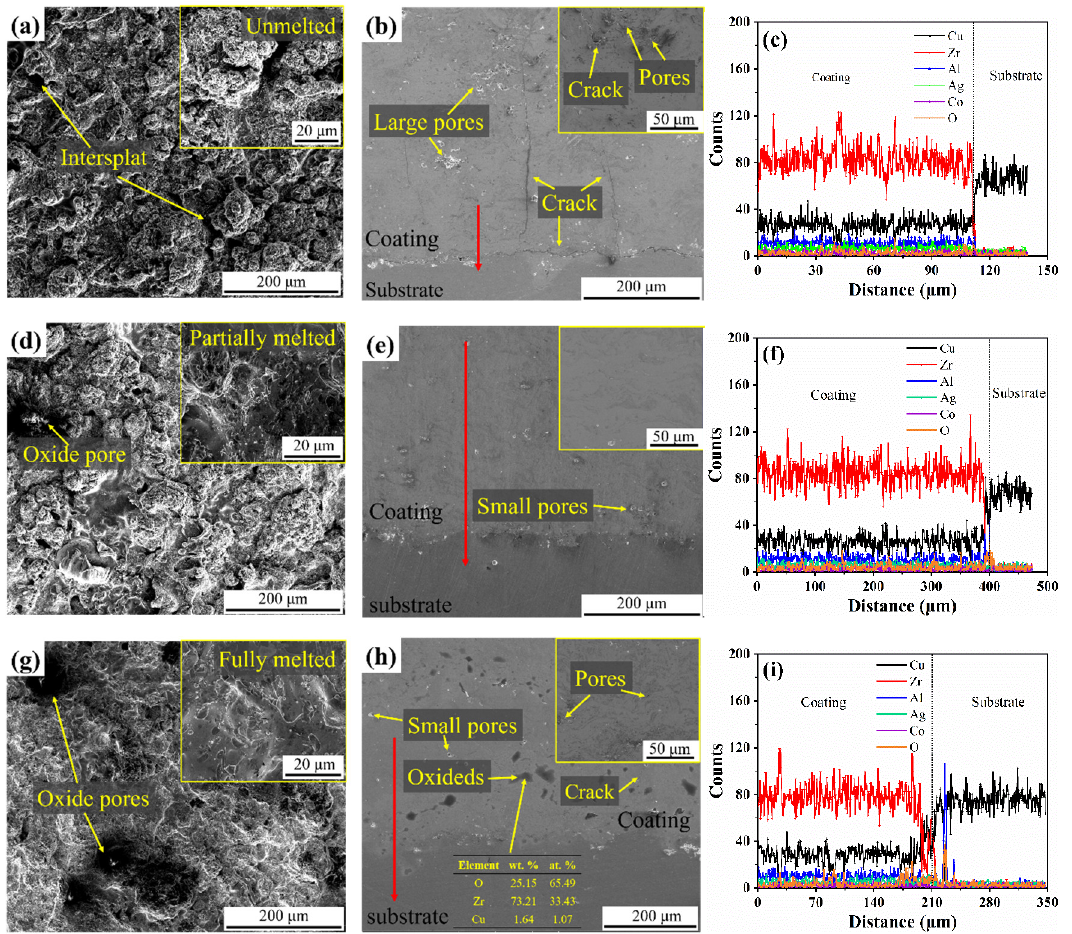
Figure 7. The surface and cross-section SEM images of ( a,b ) S1, ( d,e ) S2, and ( g,h ) S3 HVAF sprayed coatings. ( c , f , i ) are the corresponding EDS line scan results.